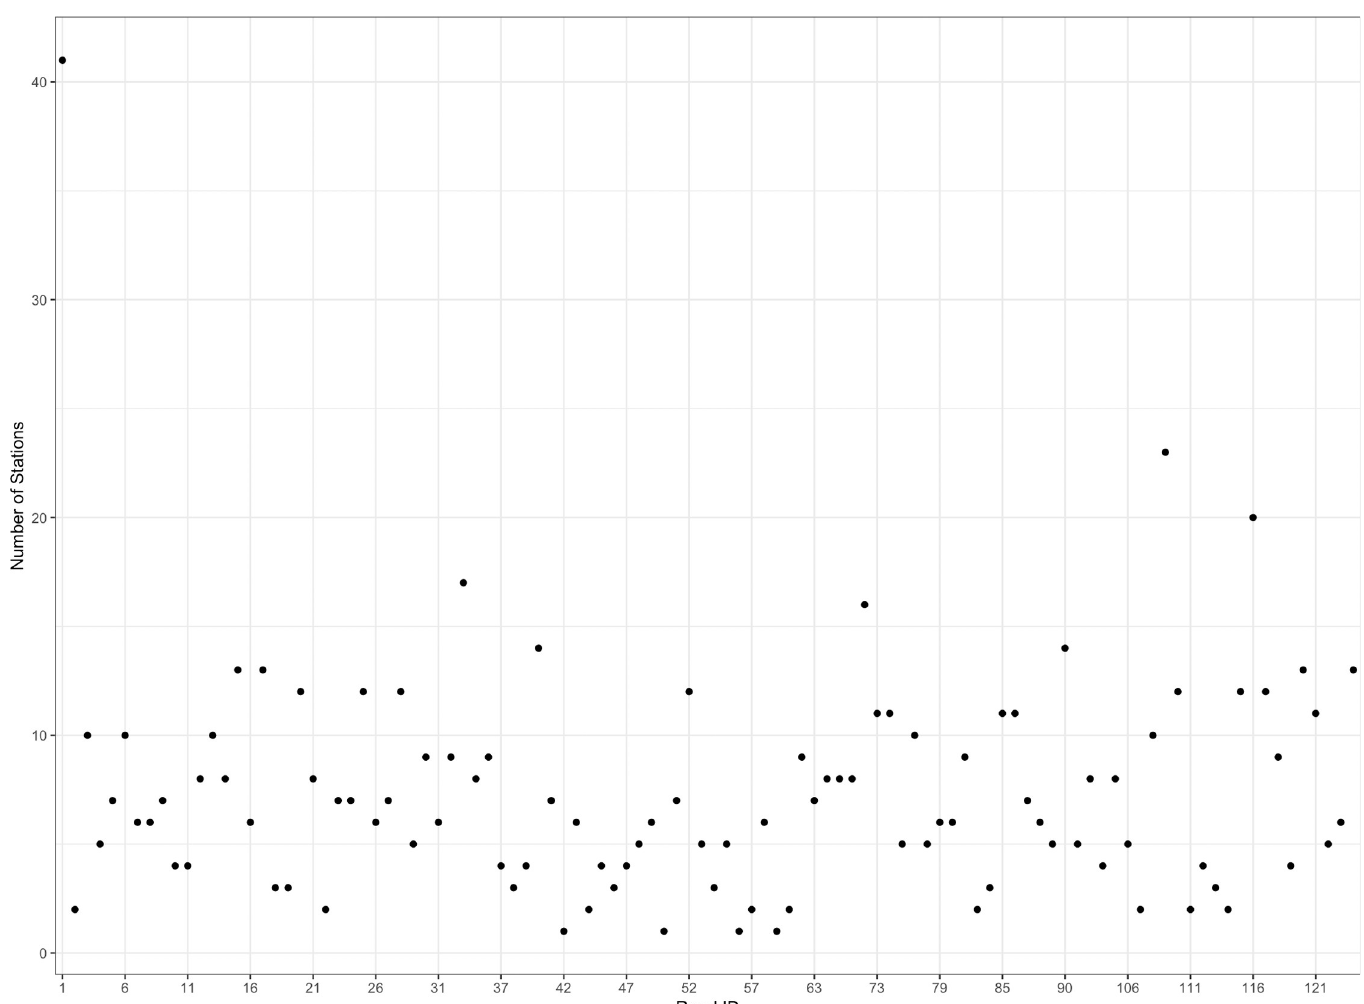
Fig 4. Summary of toll gates